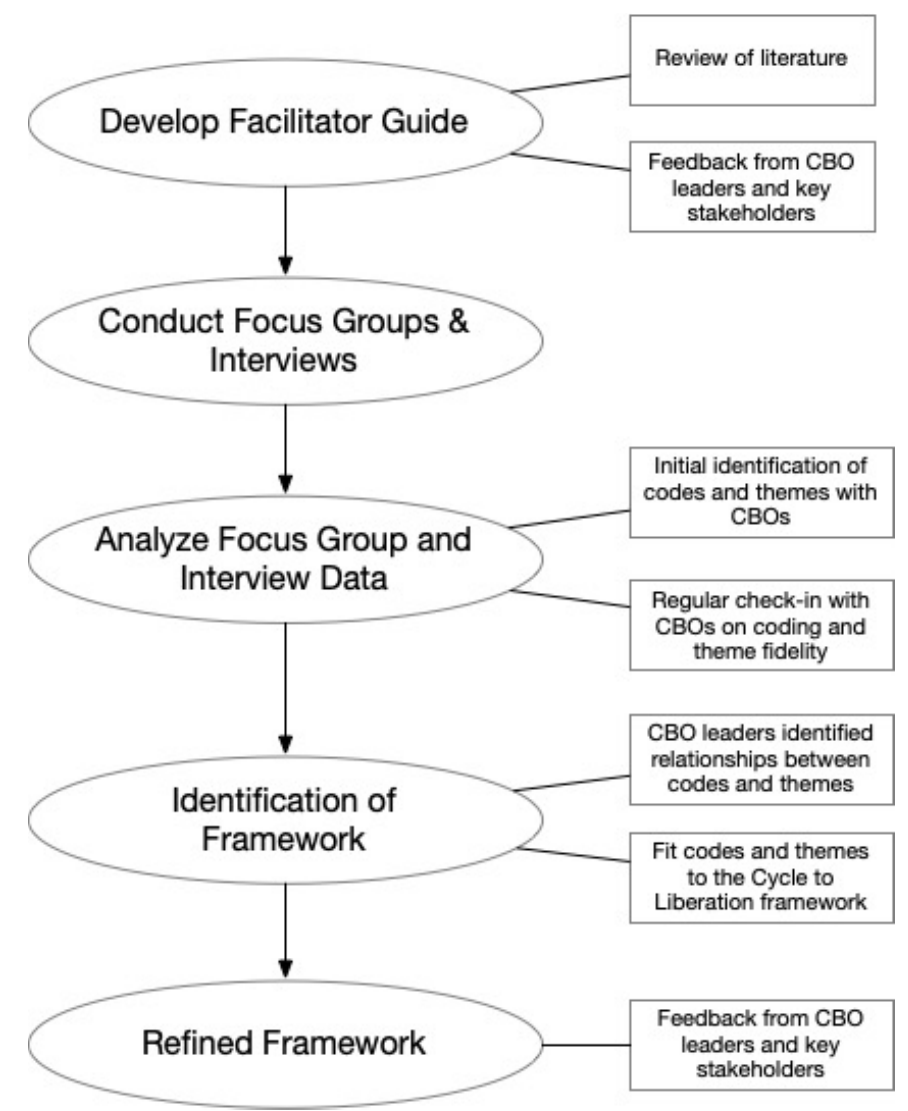
Figure 1. Methods Process. CBO: Community based organization.